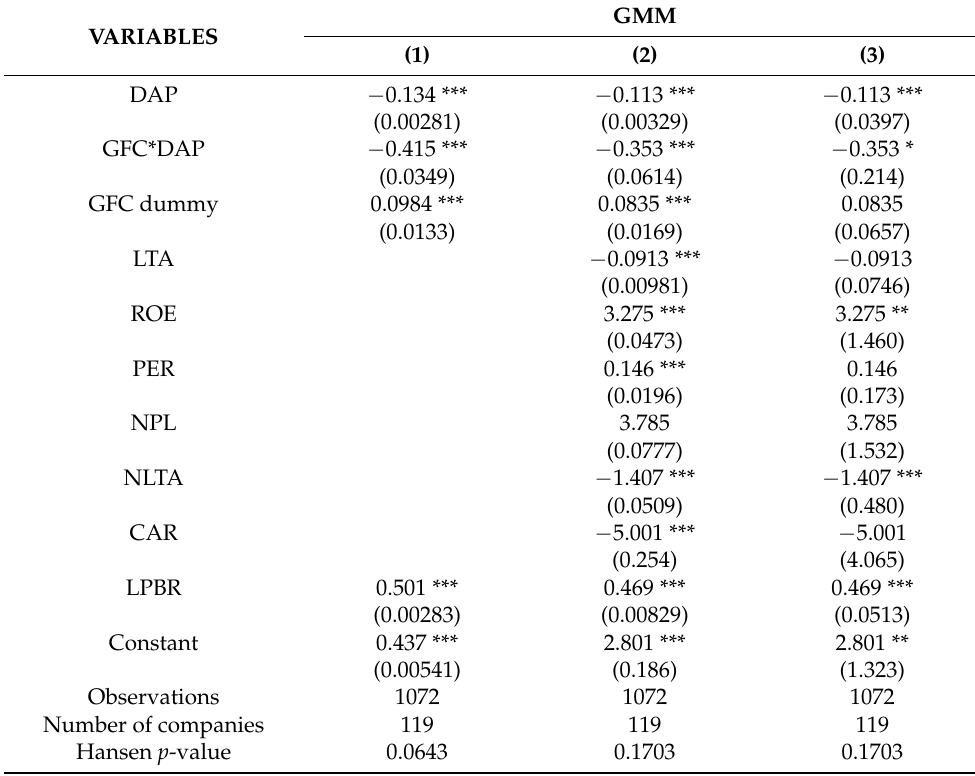
Table 5. Results of the regressions, considering the financial crisis